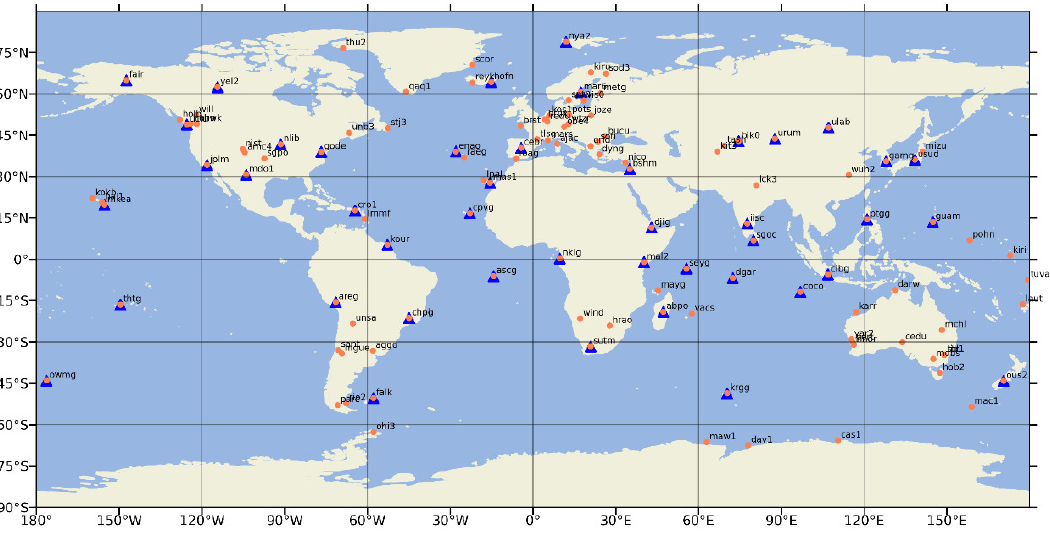
Figure 2. Distribution of the tracking stations, coral dots denote the stations used for POD, and blue triangles denote stations used for the BDS-only PPP in validations.